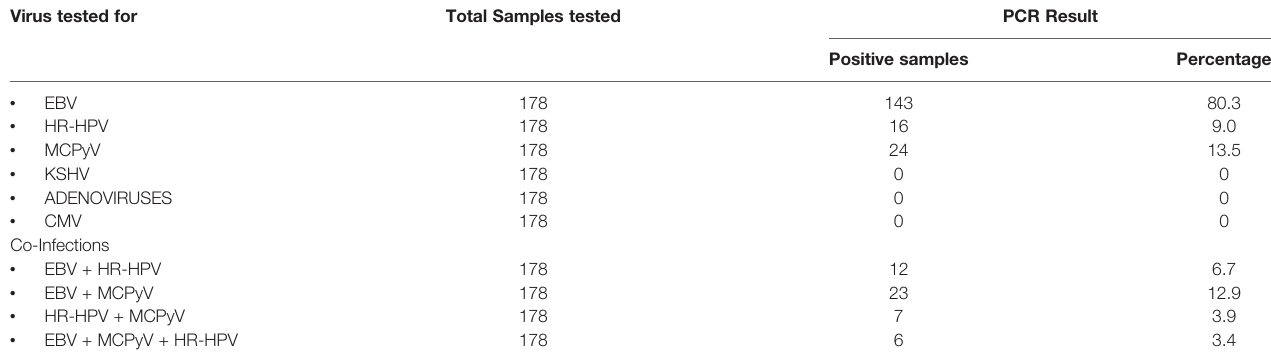
TABLE 2 | Frequency of viral infection detection in tumor sample by PCR. Virus tested for